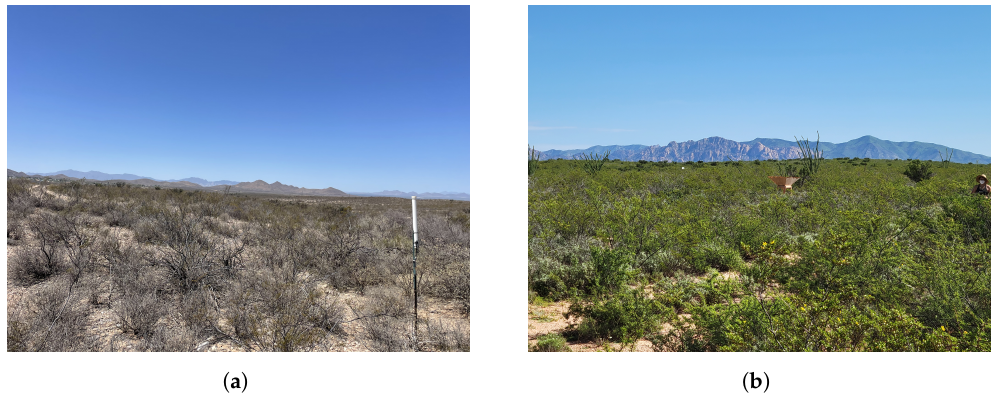
Figure 2. Photos of WG taken in the dry season and monsoon season: ( a ) Photo was taken in May 2022 [credit: Piril Nergis]; ( b ) Photo was taken in Aug 2022 [credit: Asem Melebari].